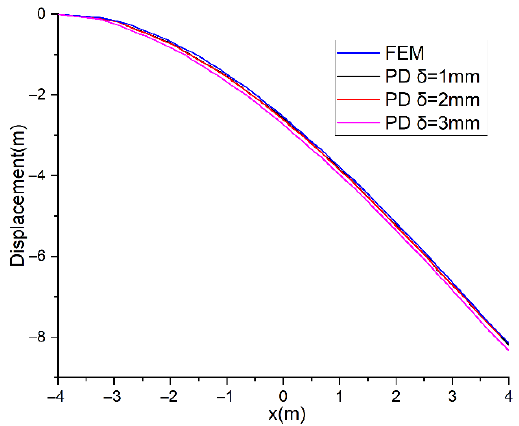
Figure 5. Vertical displacement on central axis of the beam.